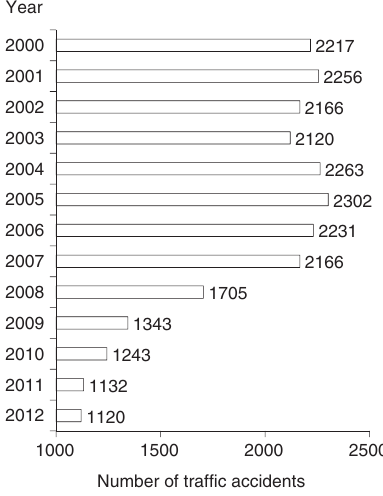
Fig. 3. The dynamics of traffic accidents registered by the Traffic Police of Lithuania in 2000 (cid:2) 2012